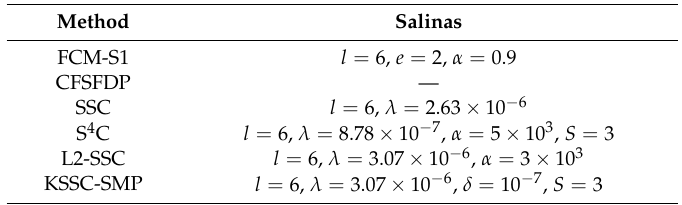
Table 3. Parameters of each clustering method for the Salinas image: fuzzy c -means with spatial information (FCM-S1), clustering by fast search and find of density peaks (CFSFDP), sparse subspace clustering (SSC), spectral-spatial sparse subspace clustering (S 4 C), (cid:96) 2 -norm regularized sparse subspace clustering (L2-SSC), and kernel sparse subspace clustering with a spatial max pooling operation